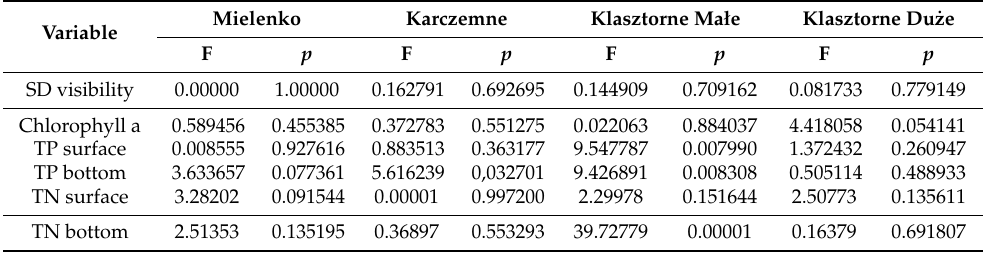
Table 3. Results of statistical analyses (F-Fisher coefficient, p -significance